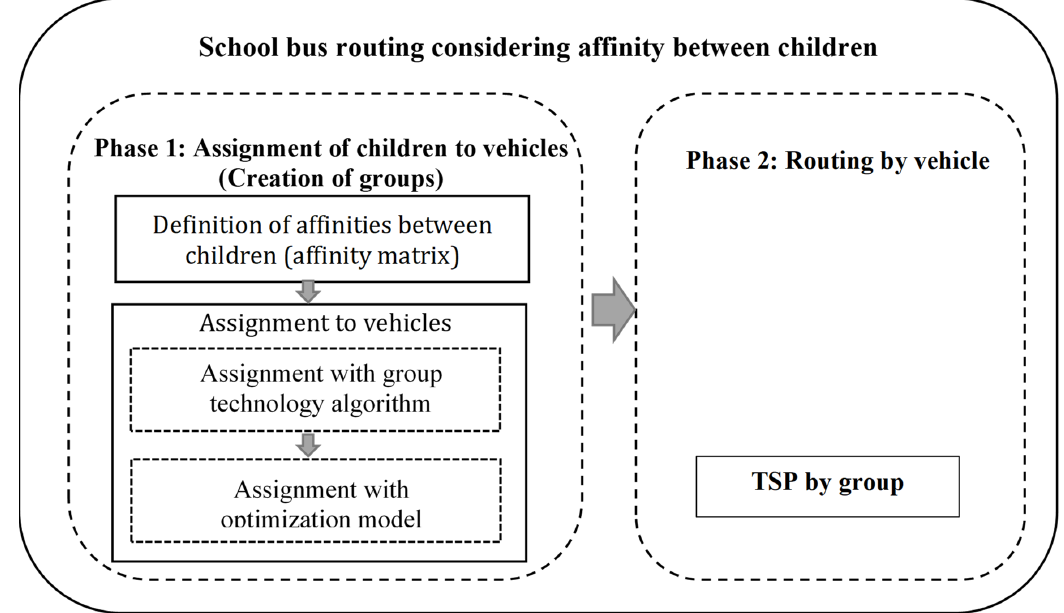
Fig. 4. Phases of the proposed methodology for the school bus routing